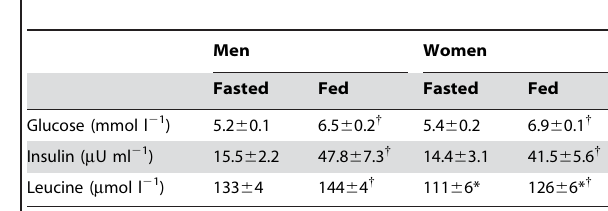
Table 3. Plasma glucose, insulin, and leucine